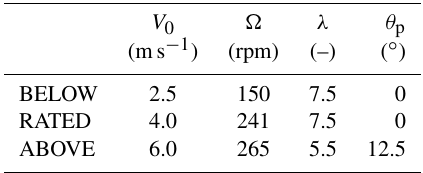
Table 2. Operating conditions tested in